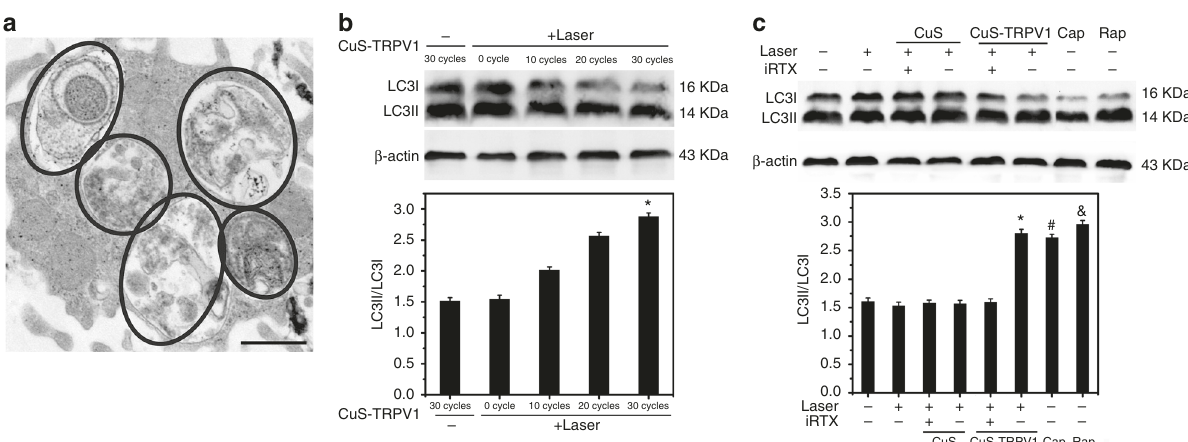
Fig. 4 Photothermal activation of TRPV1 by CuS-TRPV1 rescued the autophagy impaired by oxLDL in VSMCs. 80 μ g mL − 1 oxLDL-pretreated VSMCs were incubated with CuS-TRPV1 (0.4 mg mL − 1 ) and irradiated by the 980 nm laser (5 W cm − 2 ). a Representative TEM images of autophagosomes in VSMCs after 30 irradiation cycles. Black circles were added to outline the double-membrane structures of autophagosomes. Images are representative of three independent wells. Scale bar = 1 μ m. b Western blot analysis of LC3II/LC3I ratio at the indicated irradiation cycle. β -actin was used as a loading control. Data are shown as mean ± S.D. of three independent experiments, and analyzed by Student ’ s t -test. * P < 0.05 vs. 0 cycle. c Western blot analysis of LC3II/ LC3I ratio in VSMCs after indicated treatments. Capsaicin (Cap, 1 μ M) and rapamycin (Rap, 10 nM) were used as positive controls and CuS (0.4 mg mL − 1 ) was used as a negative control. iRTX (1 μ M) was used as a TRPV1 antagonist. Laser: 30 cycles. β -actin was used as a loading control. Data are shown as mean ± S.D. of three independent experiments, and analyzed by Student ’ s t -test. * P < 0.05 for CuS-TRPV1 vs. untreated group, # P < 0.05 for Cap vs. untreated group, & P < 0.05 for Rap vs. untreated